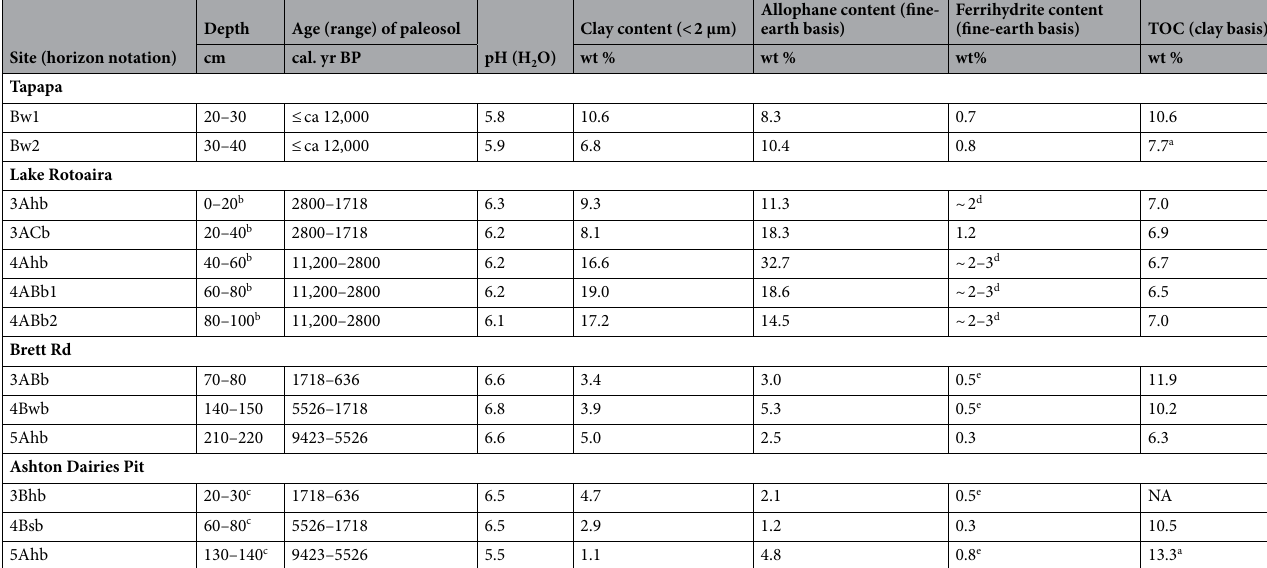
Table 1. Depths, ages, and pH values of the soils and buried-soil horizons at the four sites, and their clay, allophane, ferrihydrite, and total organic carbon (TOC) contents. Notes for different symbols are: a from equivalent buried soil horizons on the same tephras at nearby sites identified using pedostratigraphy and tephrochronology (from Lowe and Tonkin 18 , after Green 47 ); b below the datum line of the base of (non-welded) Taupo ignimbrite (Fig. 3); c below the datum line of the base of Kaharoa tephra (Fig. 3); d estimated likely value/range of values associated with similar horizons developed on equivalent Holocene andesitic tephras in the region 48,49 ; e estimated from equivalent buried soil horizons (identified using pedostratigraphy and tephrochronology) on the same tephras at nearby sites 48,49 . NA indicates data not